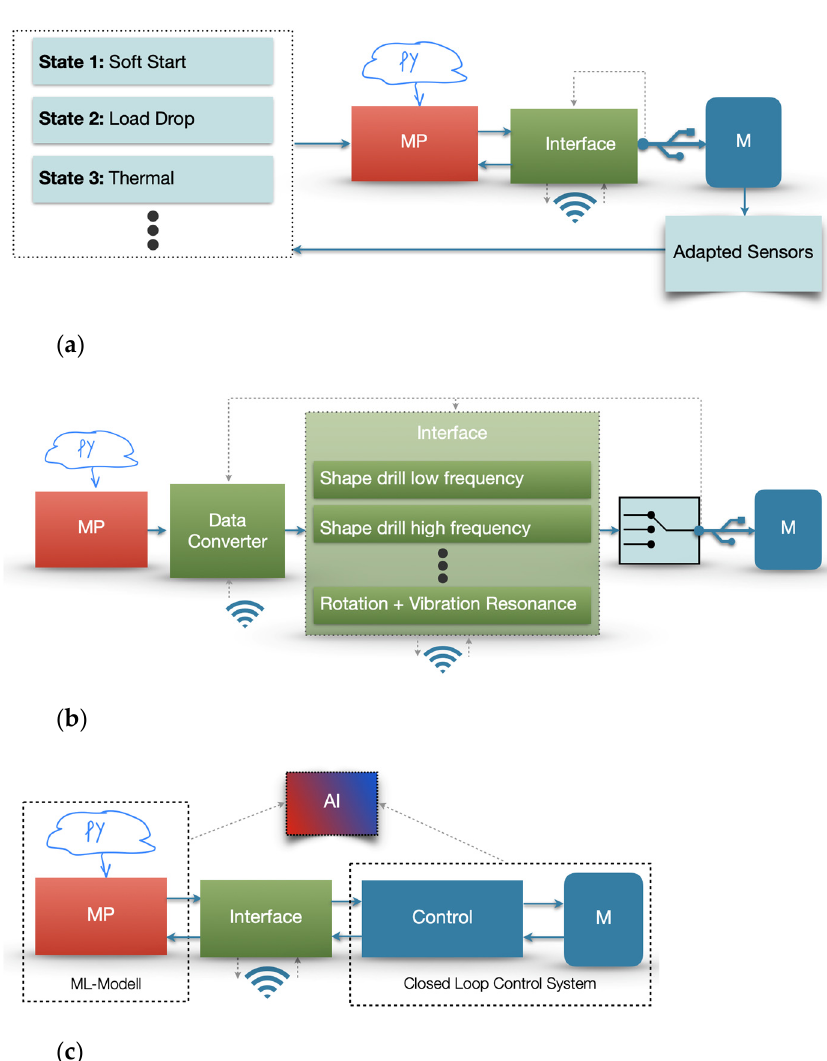
Figure 4. Switching between control systems for optimal system control: ( a ) control on state intervals; ( b ) switching between control of different operating modes; ( c ) smart control with a combination of classic control and machine learning for repeatable processes.